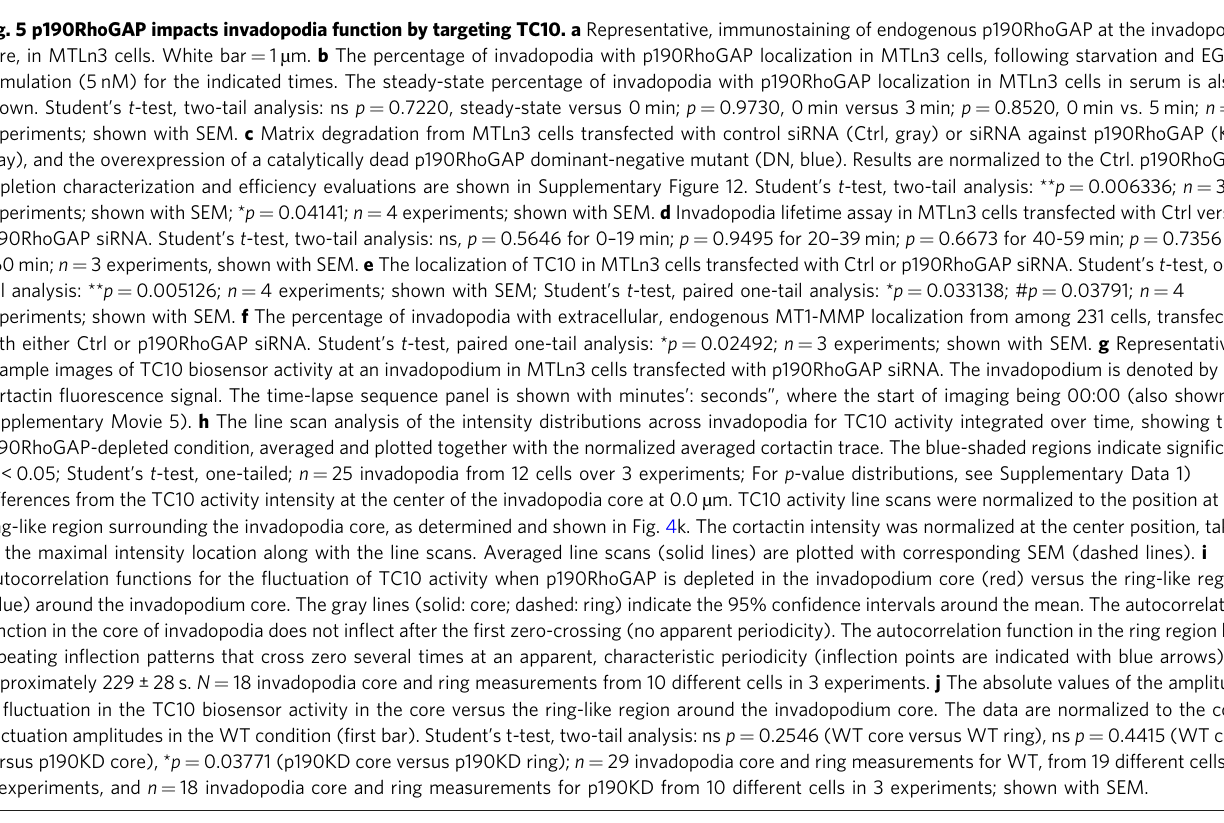
Fig. 5 p190RhoGAP impacts invadopodia function by targeting TC10. a Representative, immunostaining of endogenous p190RhoGAP at the invadopodia core, in MTLn3 cells. White bar = 1 µ m. b The percentage of invadopodia with p190RhoGAP localization in MTLn3 cells, following starvation and EGF stimulation (5 nM) for the indicated times. The steady-state percentage of invadopodia with p190RhoGAP localization in MTLn3 cells in serum is also shown. Student ’ s t -test, two-tail analysis: ns p = 0.7220, steady-state versus 0 min; p = 0.9730, 0 min versus 3 min; p = 0.8520, 0 min vs. 5 min; n =